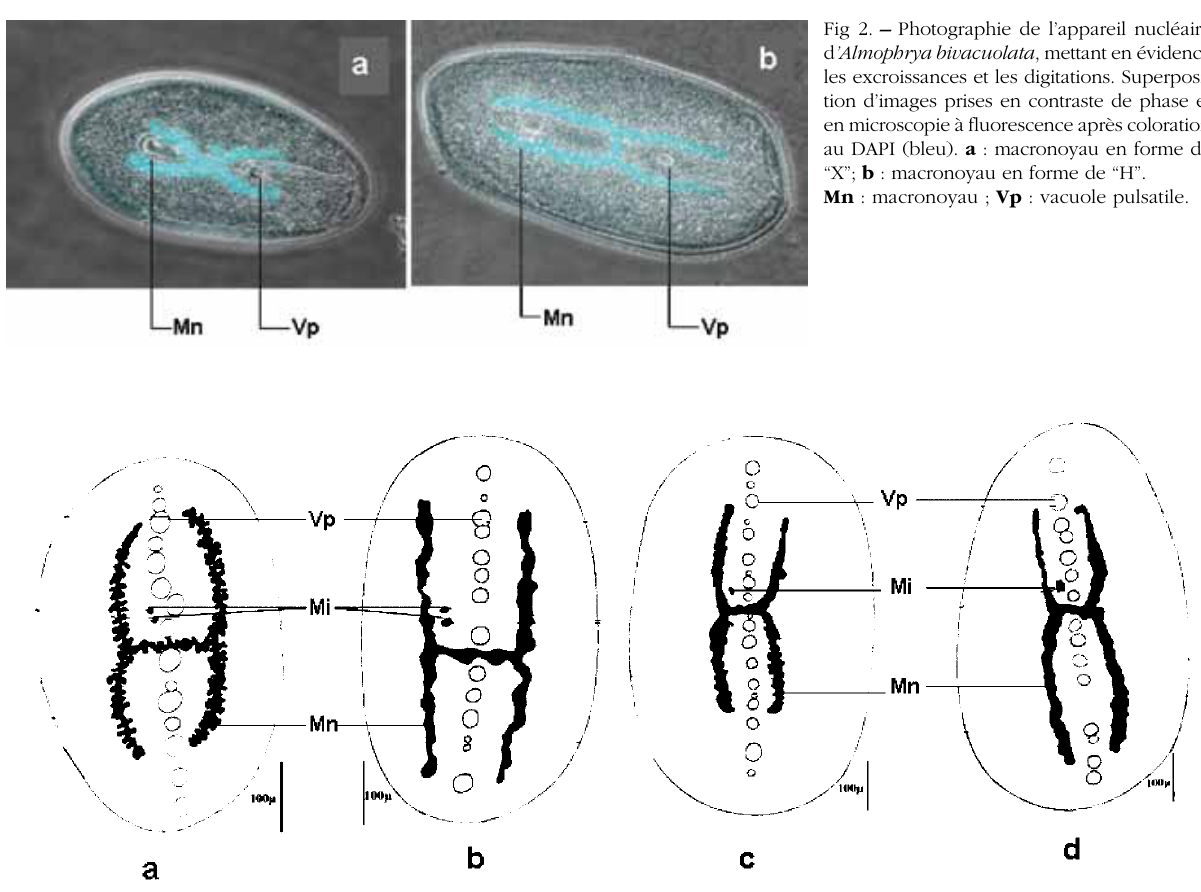
Fig 3. - Variations morphologiques de l’appareil nucléaire d’ Almophrya mediovacuolata dans les cellules classées par ordre de taille. a : macronoyau en “H” très dentelé, à aspect empilé, et deux micronoyaux ; b : macronoyau en “H” moins dentelé et deux micronoyaux ; c : macronoyau en “H” peu dentelé et un micronoyau ; d : macronoyau en “H” non dentelé et un micronoyau. Vp : vacuole pulsatile ; Mn : macronoyau ; Mi :